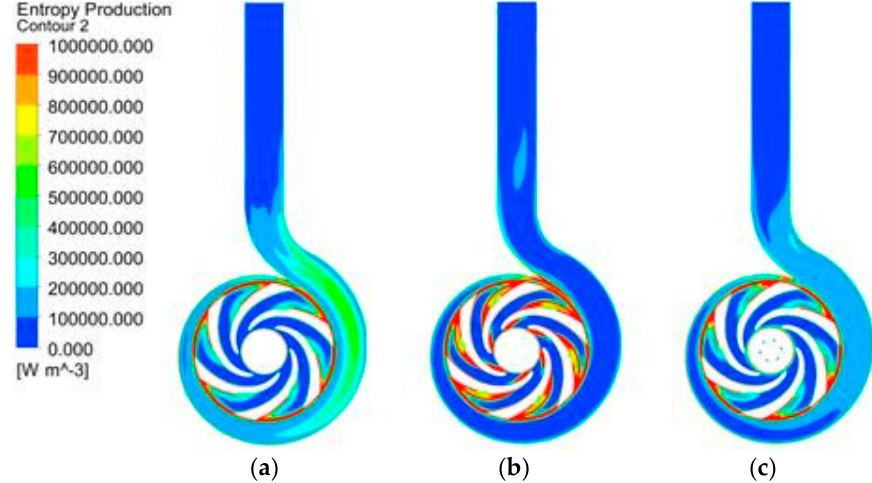
Figure 9. Comparison of the entropy production on the X – Y plane of the pump without balancing holes and the pumps with six Type A and B balancing holes of 4 mm diameter: ( a ) without balancing holes; ( b ) with Type A balancing holes; ( c ) with Type B balancing holes.